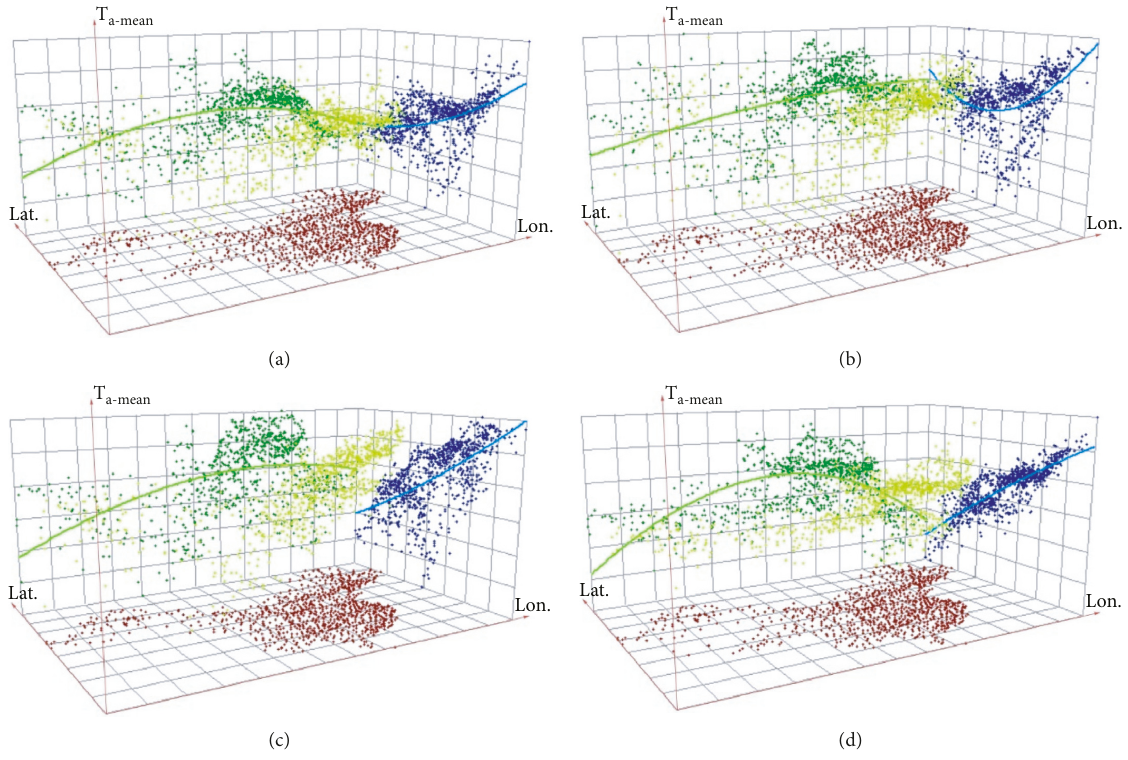
Figure 2: Boxplots of (a) the standard deviations ( σ ) and (b) the limits of the 95% confidence intervals of the estimated values of T the applicable regression models in the 334 supplemented locations.